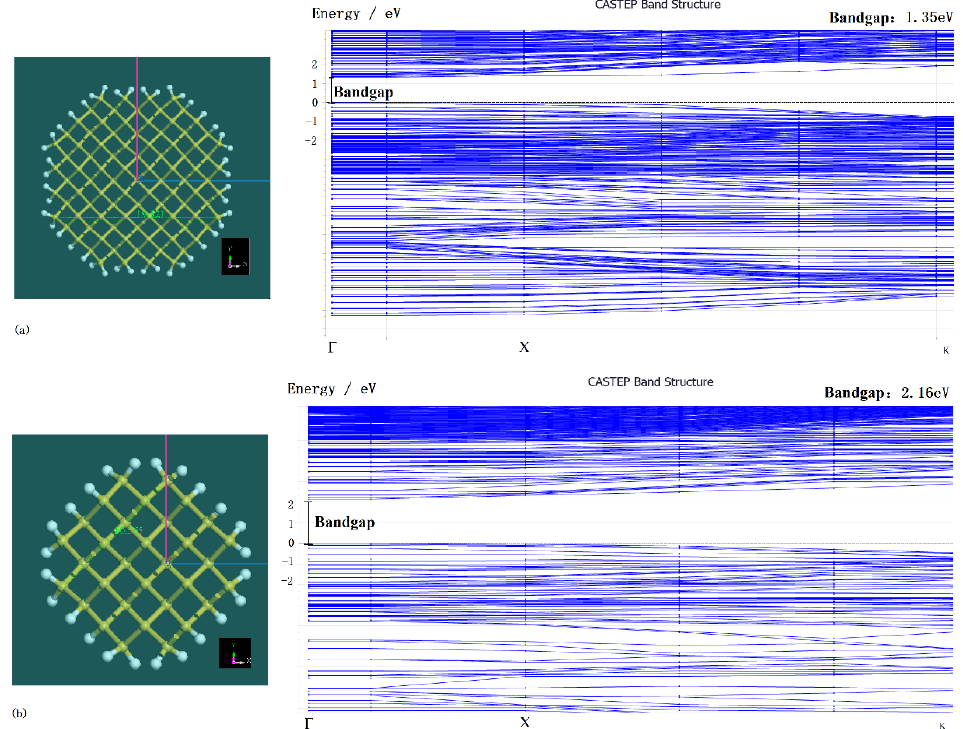
Figure 4. Energy change of bandgap with various radius of Si NW in simulation. ( a )Si NW model with diameter of 2 nm and its energy band structure calculated ( b ) Si NW model with diameter of 1nm and its energy band structure calculated.